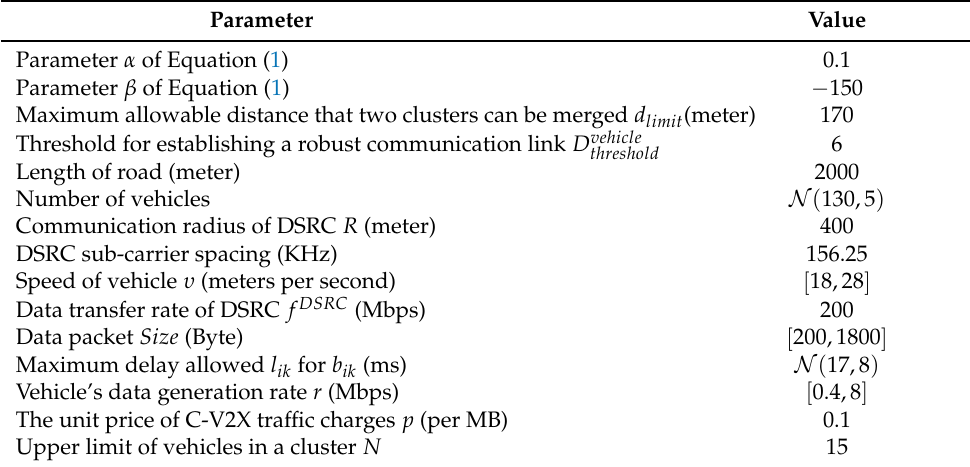
Table 3. Experimental parameter